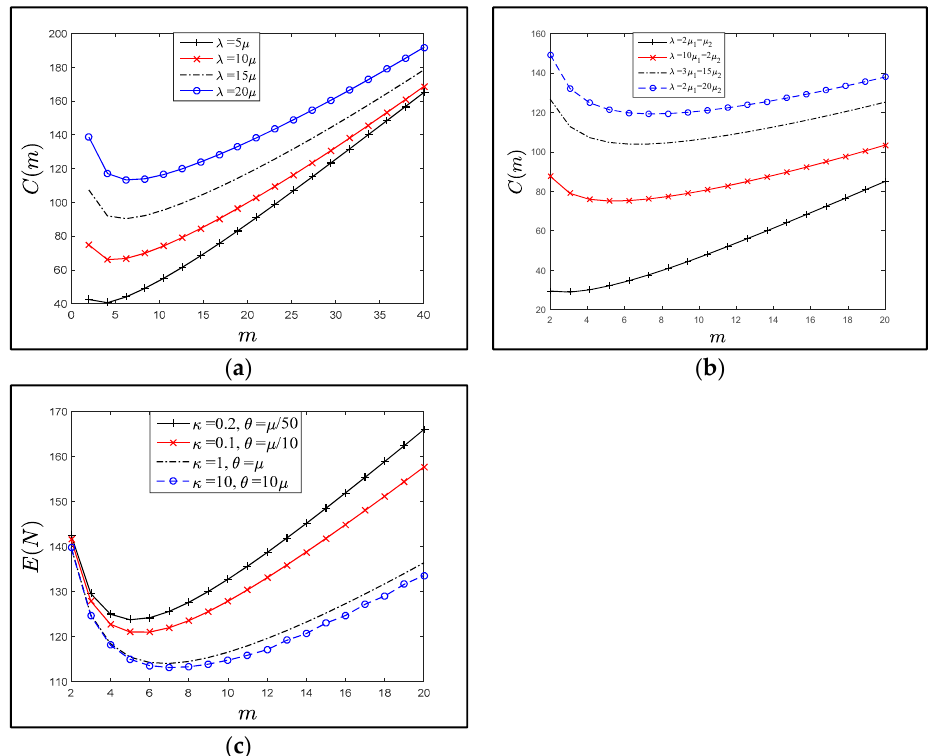
Figure 8. The cost function C ( m ) when α = β = 1, with different residence time distributions as in ( a – c ). ( a ) The residence time is exponential distributed. ( b ) The residence time is hypo exponential distributed. ( c ) The residence time is gamma distributed.